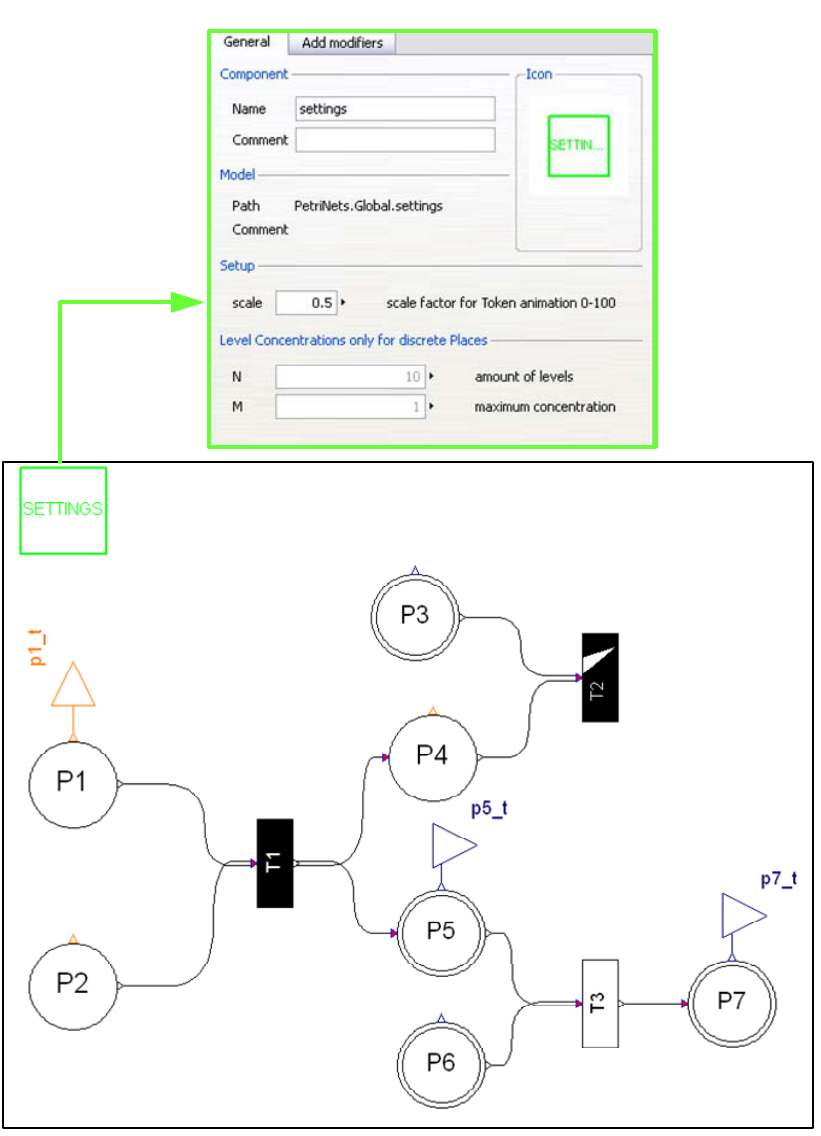
Figure 19: Scaling of the redness degree by the Settings-component of the Global